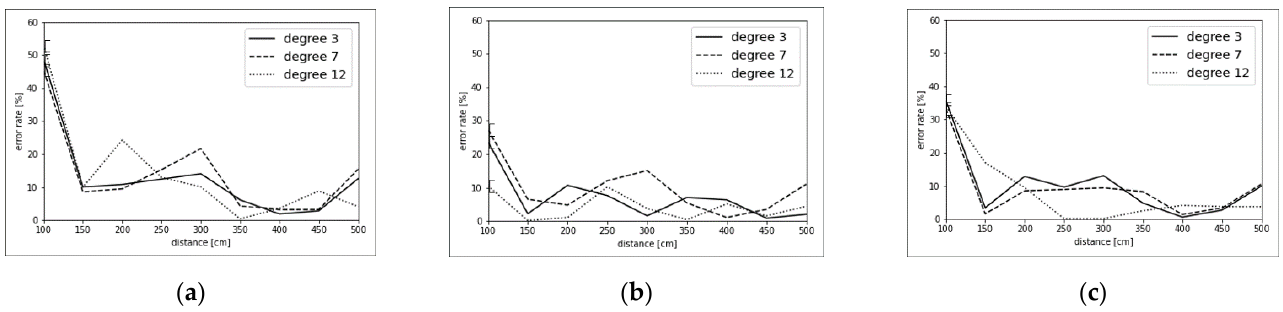
Figure 9. Test results with respect to varying baselines and angles at a height of 30 cm: ( a ) error rates corresponding to various angles and a baseline of 10 cm, ( b ) error rates corresponding to various angles and a baseline of 20 cm, ( c ) error rates corresponding to various angles at a baseline of 30 cm.